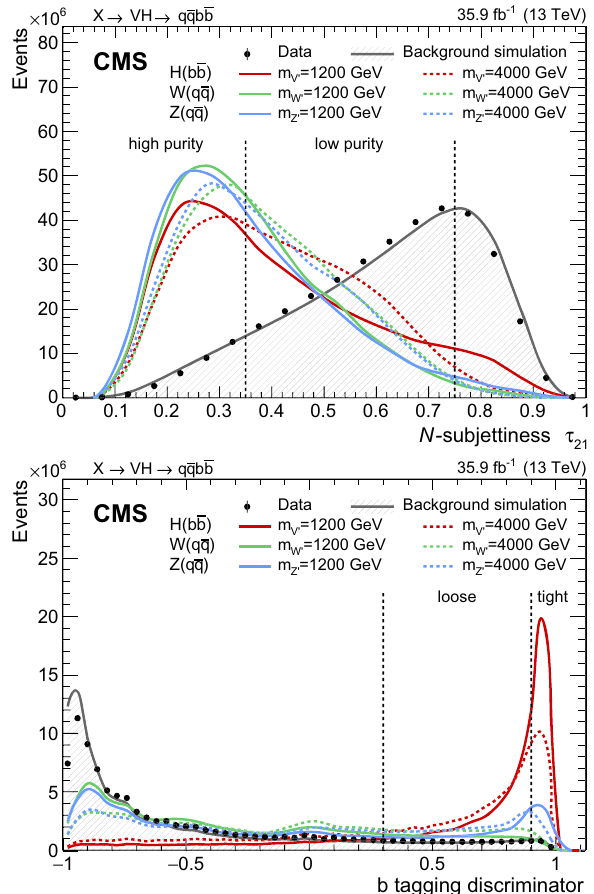
Fig. 2 Distribution of the N -subjettiness τ 21 (upper) and b tagging discriminator output (lower) after the kinematic selections on the two jets, for data, simulated background, and signal. The distributions are normalizedtothenumberofeventsobservedindata.Thedashedvertical lines represent the boundaries between the categories as described in the